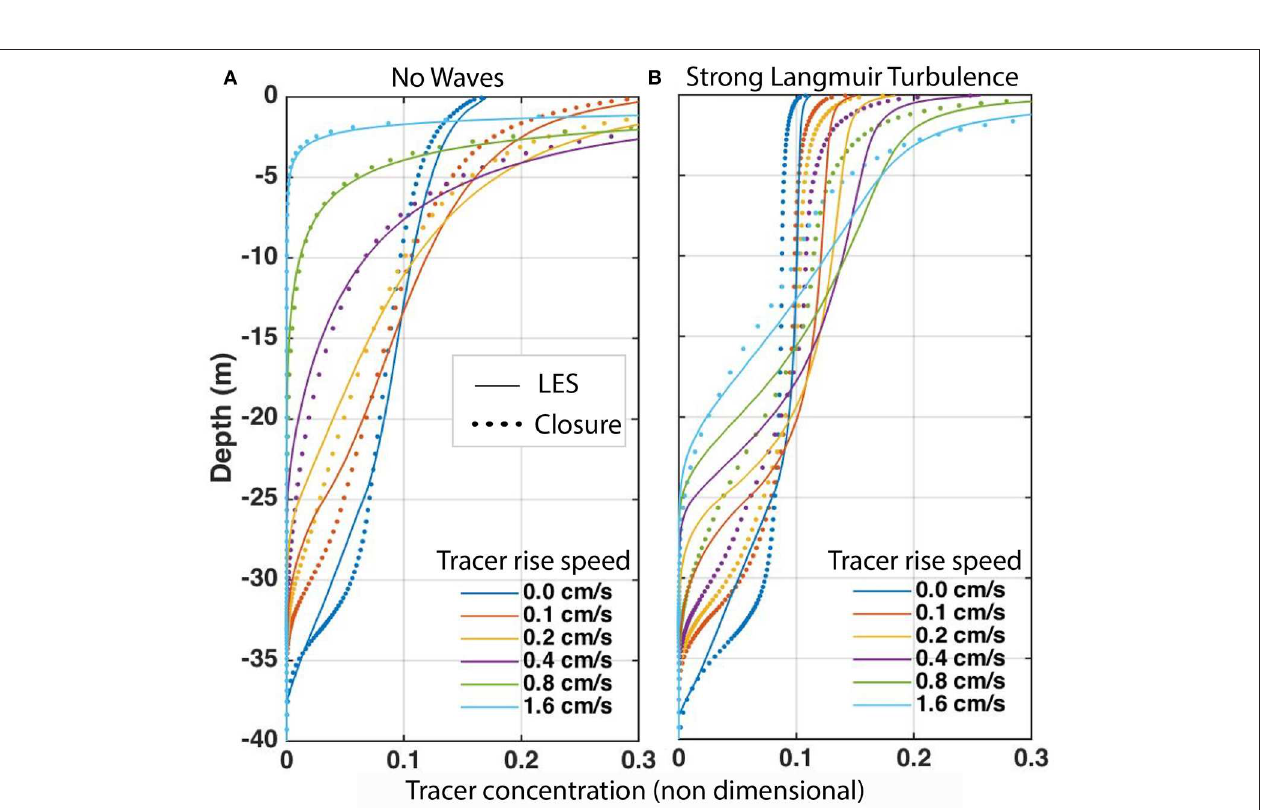
FIGURE 15 | Profiles of concentrations of buoyant tracers with varying rise velocity in an ocean surface mixed layer (H = 33 m), driven by surface winds U 10 = 10 ms − 1 are shown from LES simulations (lines) with (A) and without (B) strong Langmuir turbulence wave forcing. These are compared with predictions (dots) from second moment closures (SMC) using the standard Mellor-Yamada 2.5 model (no Stokes drift; no nonlocal fluxes) and profiles of the concentrations produce by the new non-local SMC (NLSMC) accounting for both the CL forces and nonlocal vertical fluxes.